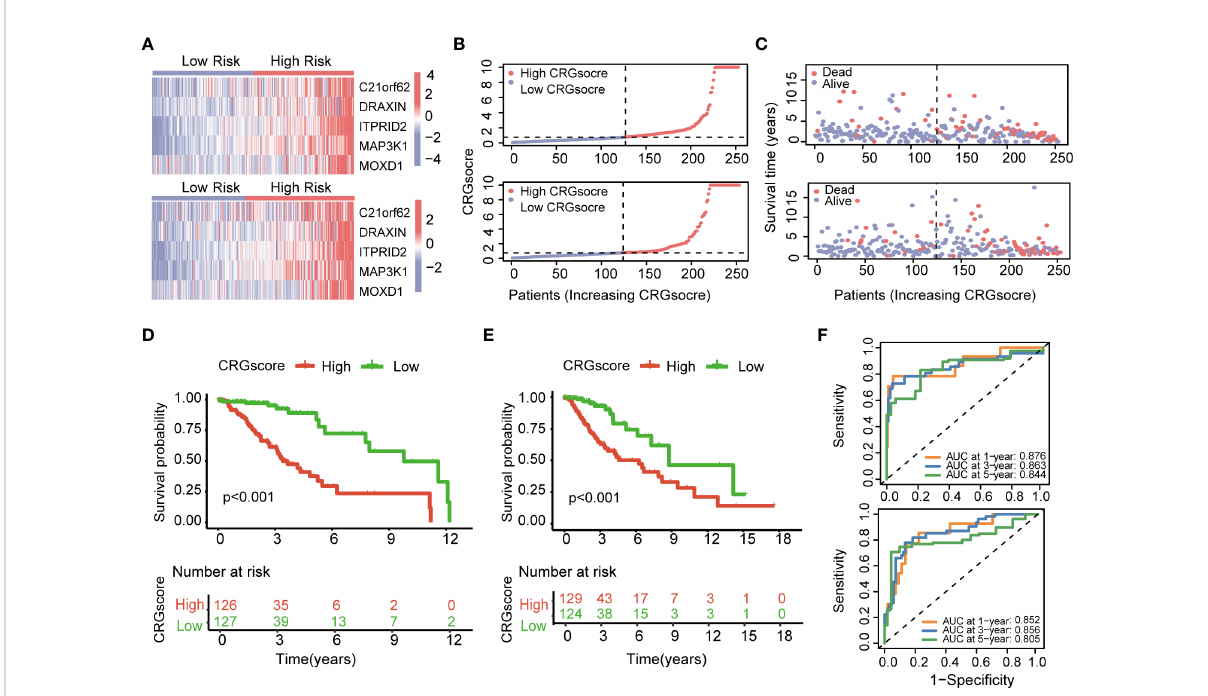
FIGURE 6 Evaluation of the cuproptosis-related prognostic model in the TCGA cohort. (A) The heatmap showed the different expressions of genes in the cuproptosis-related prognostic model between the high- and low-risk groups in TCGA training and test cohorts. (B) Distribution of the CRG score in TCGA training and testing cohorts. (C) The risk point plot showed the patterns of the survival time and survival status between the high- and low-risk groups in TCGA training and test cohorts. (D) The Kaplan – Meier OS curves for patients in the high- and low-risk groups in the TCGA training cohort (log-rank test). (E) The Kaplan – Meier OS curves for patients in the high- and low-risk groups in the TCGA testing cohort (log-rank test). (F) ROC curves showed the prognostic performance of the cuproptosis-related prognostic model in TCGA training and testing cohorts. TCGA, the Cancer Genome Atlas; CRGs, cuproptosis-related genes; OS, overall